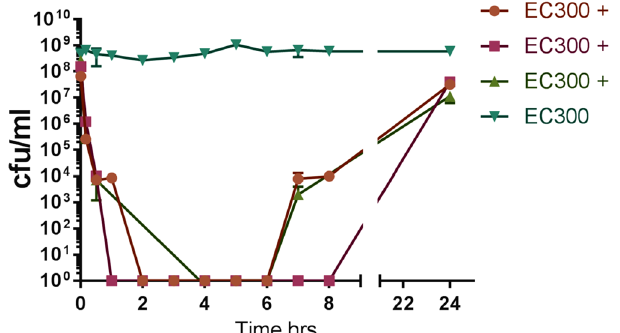
Figure 6. Kill curve of VRE EC300 using 15.6 µM gallocin D. EC300 + samples contain bacteriocin (each representing a biological triplicate), EC300 has no bacteriocin